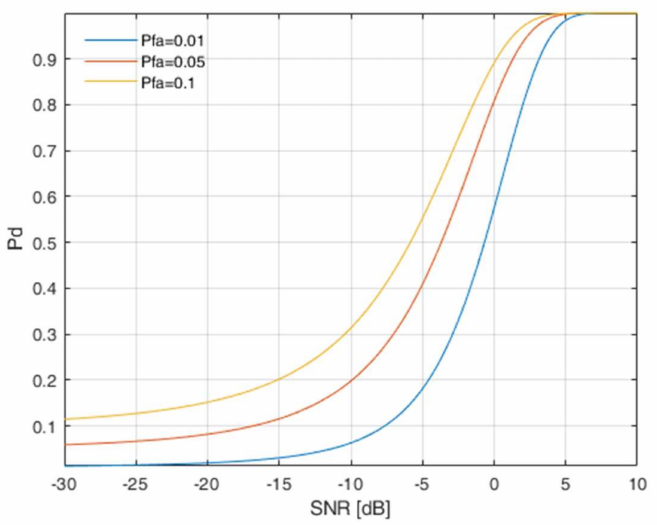
Figure 1. Probability of detection versus Signal to Noise Ratio of the considered ED – ENP